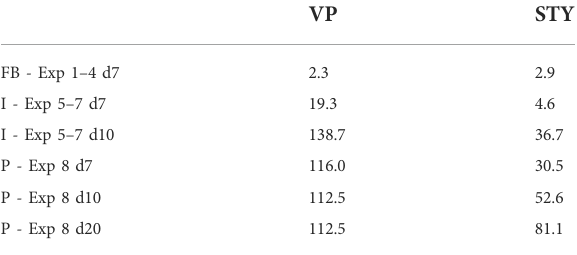
TABLE 4 Volumetric Productivity (VP — 10 6 cells/mL.day) and Space- Time Yield (STY — 10 6 cells/mL.day) associated with the fed-batch (FB), intensi fi ed (I) and perfusion (P) experiments at different days of culture(days7, 10and20).Metricscalculated followingthestandards presented in Bausch et al. (Bausch et al.,